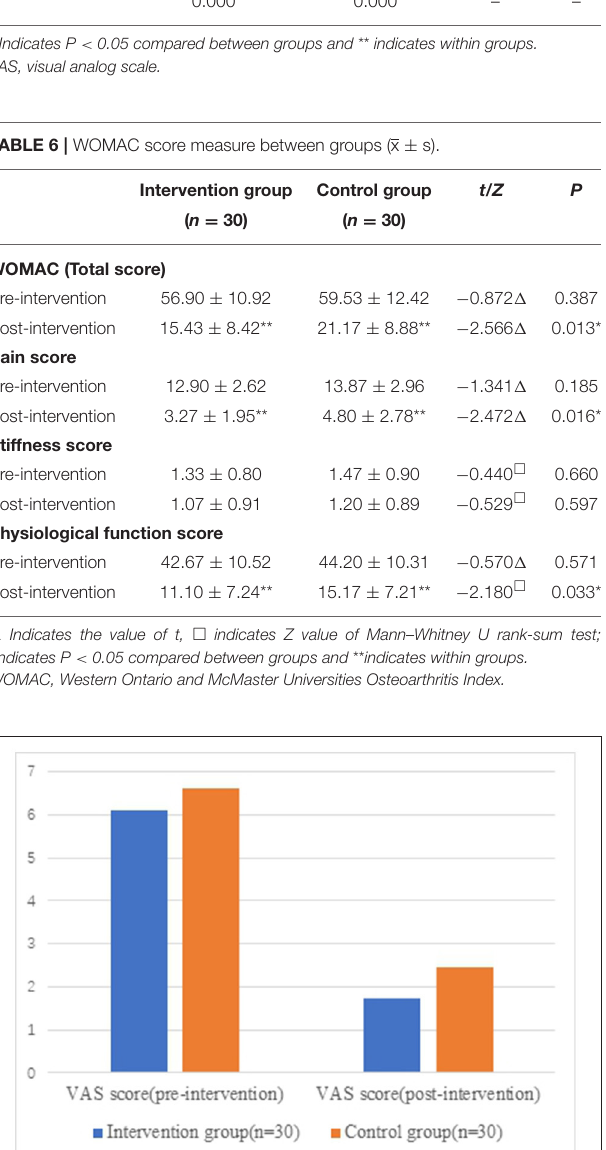
synchronized with non-invasive cardiac output was formulated for the patients with KOA, and the influence of